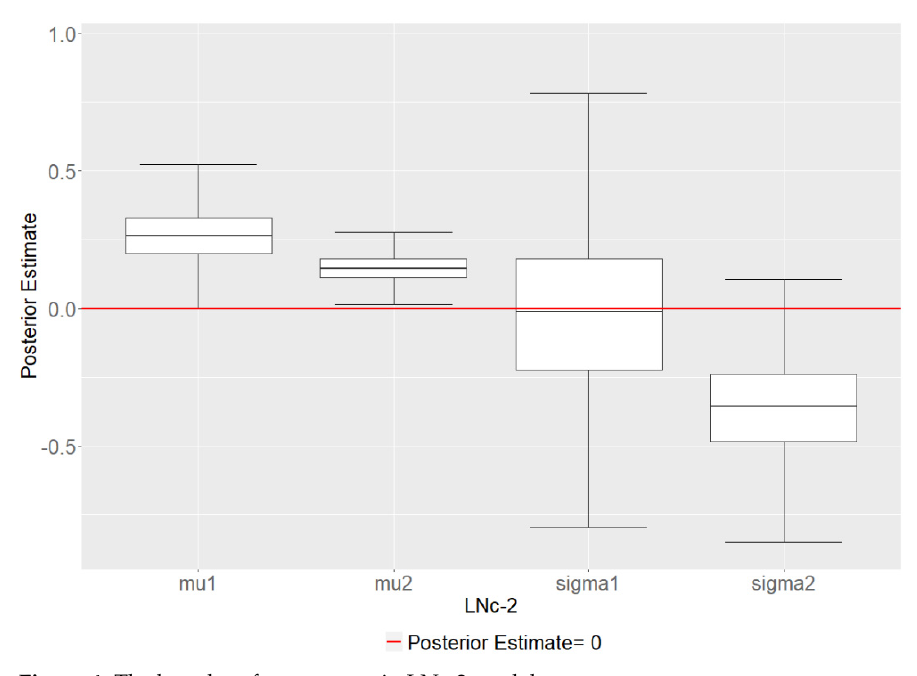
Figure 5. The PP-plot of the optimal models for each case. To obtain the preferred model for each case, the DIC and AIC are compared in Table 3. The above results showed that the model LNt-2 and the model LN C -3 performed the best in Case 2 and Case 3 which represent the time-varying and physical-based